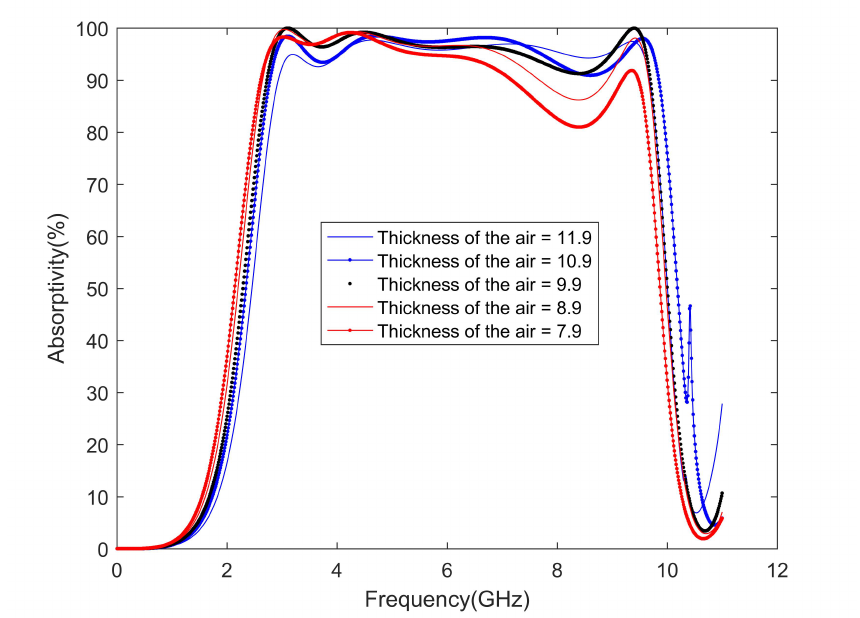
Figure 7. Simulated absorptivity for different thicknesses of the air